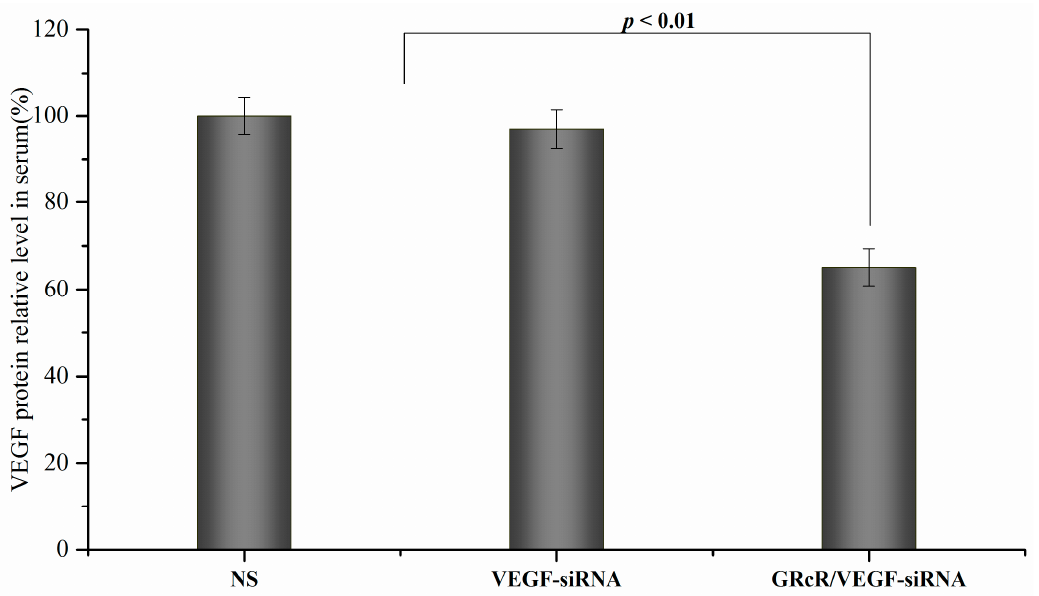
Figure 20. Serum VEGF level ELISA. The data was presented as the mean ± SD, n = 5.